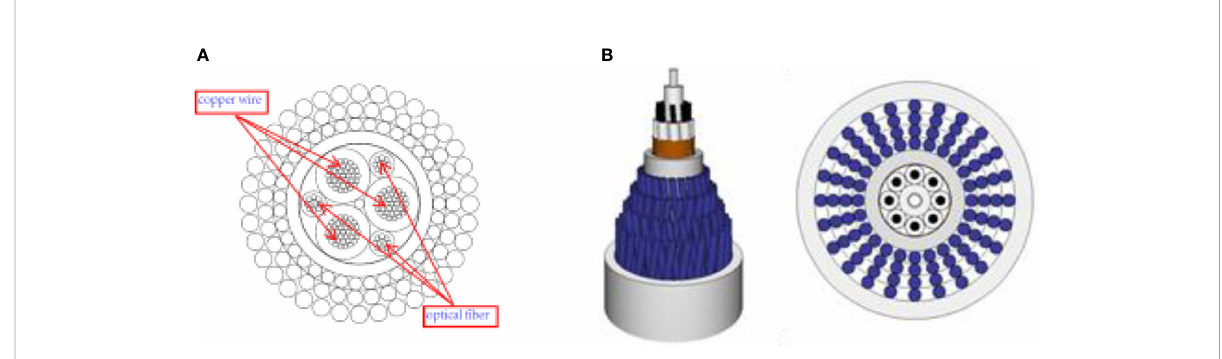
FIGURE 6 Section view of steel-wire armored EOM cable and vectran- fi ber EOM cable. (A) Rochester Engineered Cable NO.A302351. (B) Vectran fi bers